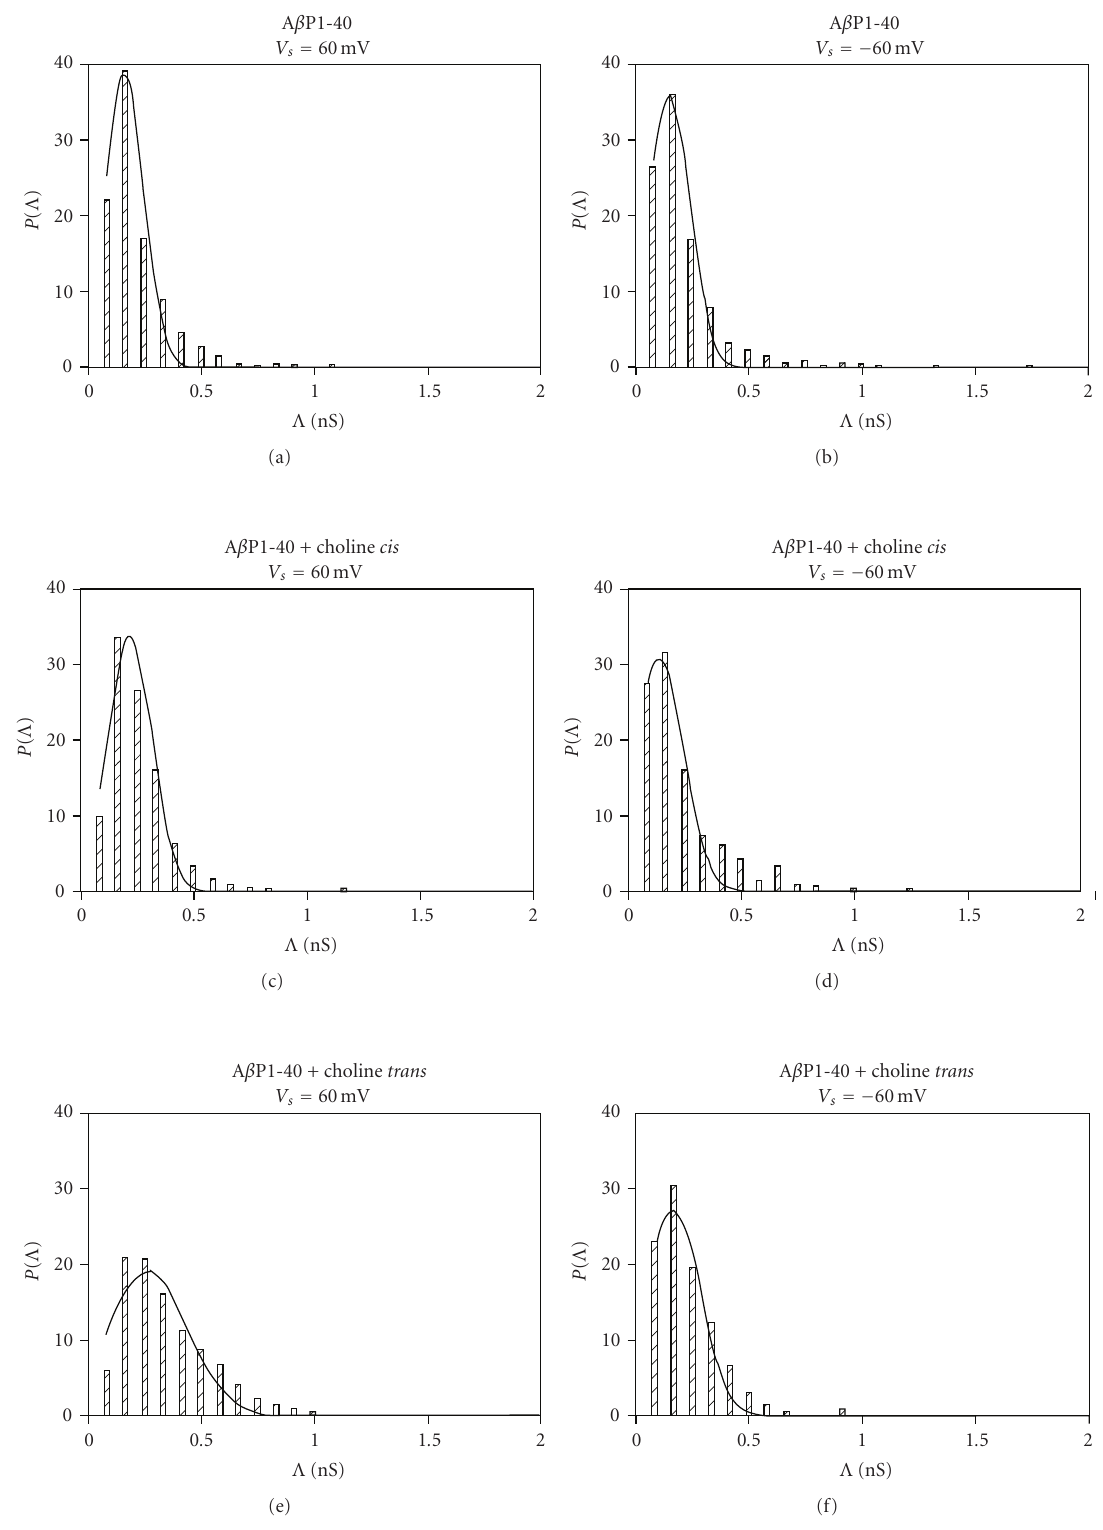
Figure 2: Amplitude histograms of A β P1-40 channel conductance. The histograms of the probability, P Λ , for the frequency of a given conductivity unit, relatives to each trace reported in Figure 1, were fitted by a Gaussian which is shown as a solid